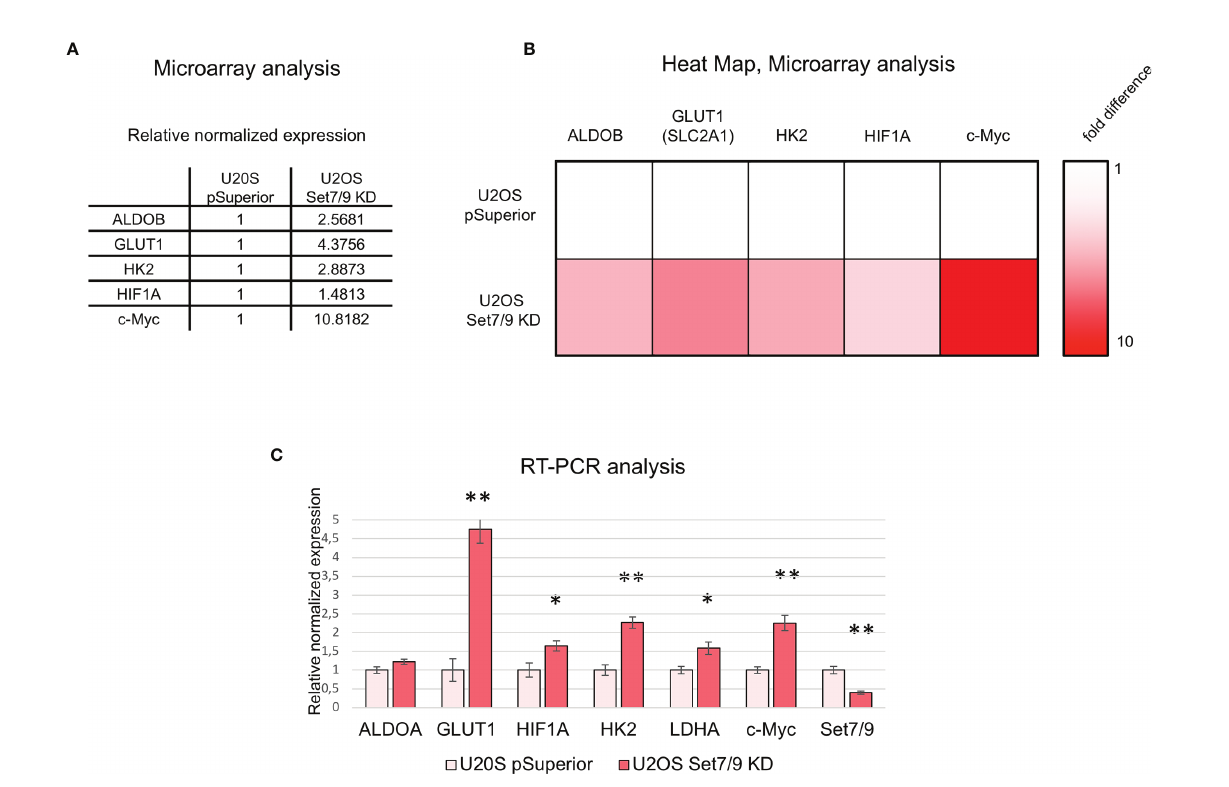
FIGURE 1 | Microarray data analysis of U2OS Set7/9KD cells. (A) Relative expression of ALDOB, GLUT1, HK2, HIF1A, and c-Myc mRNAs in U2OS cells with tetracyclin-induced Set7/9 knockdown (tet-on system) compared to control U2OS pSuperior cells. Both cell lines were treated with doxycycline for 48 h prior to microarray analysis. (B) Heat map demonstrating ALDOB, GLUT1, HK2, HIF1A, and c-Myc mRNAs expression changes in Set7/9 KD U2OS cells compared to control U2OS pSuperior cells. (C) Validation of microarray data using quantitative RT-PCR: analysis of ALDOA, GLUT1, LDHA, HK2, HIF1A, c-Myc, and Set7/9 mRNAs expression in U2OS cells with tetracyclin-induced Set7/9 knock-down (Tet-on system) compared to control U2OS pSuperior cells. *p < 0.05; **p <